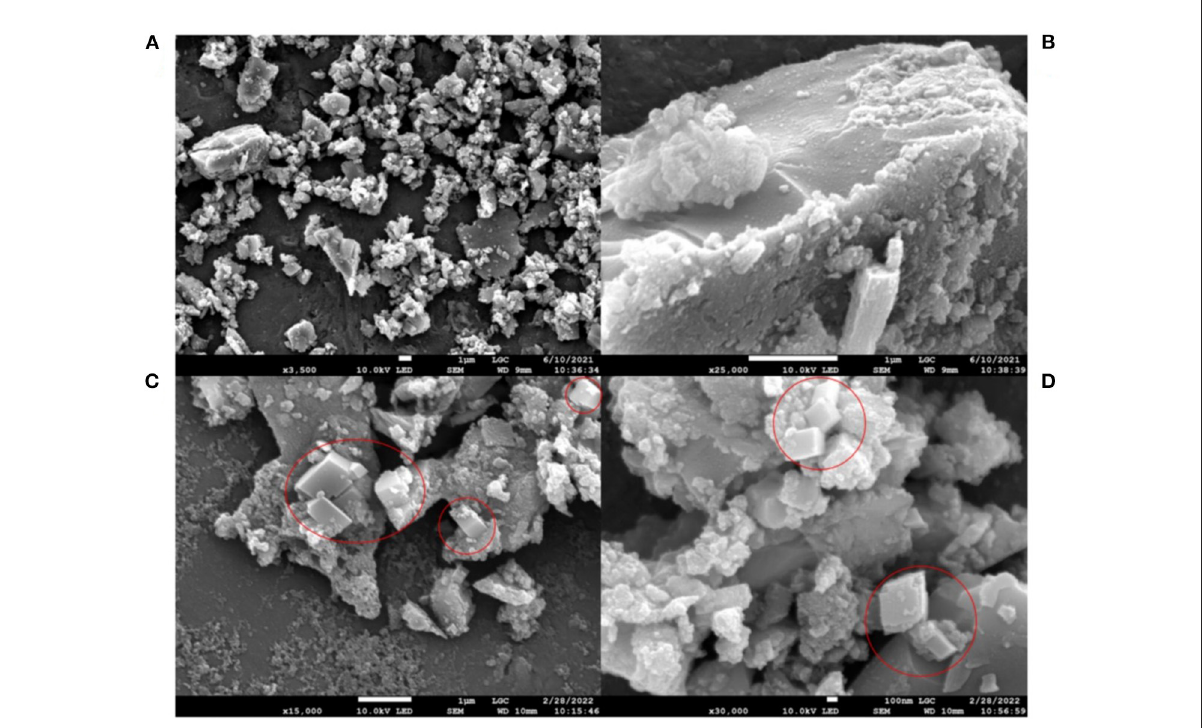
FIGURE7 SEM images of reaction products from AC mode after 15min of reaction partially covered with reaction products: (A,C) low resolution, (B,D) high resolution (red circle: